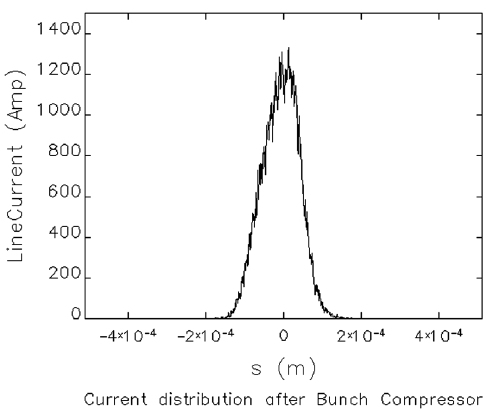
FIG. 10. The current distribution along the bunch at the end of zigzag bunch